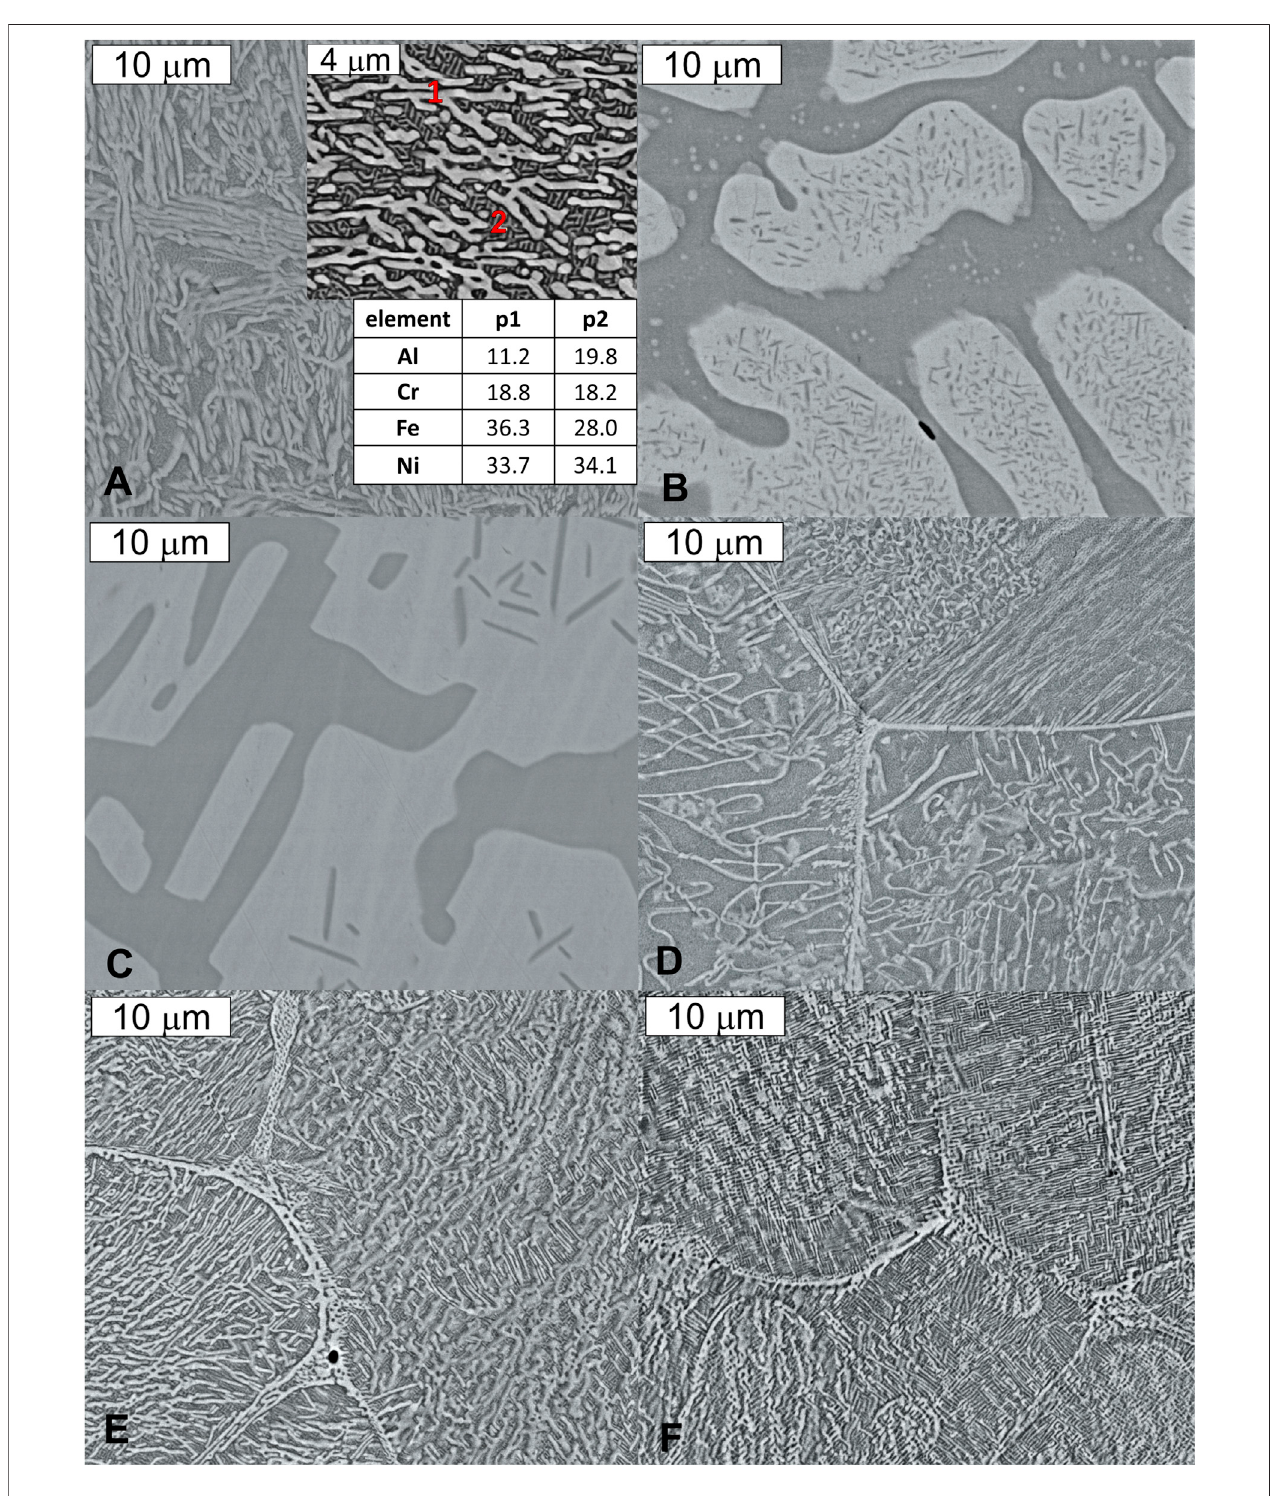
FIGURE 1 | Microstructures of AlCrFe 2 Ni 2 (A) , AlCrFe 2 Ni 2 (1) (B) , AlCrFe 2 Ni 2 (2) (C) , AlCrFe 2 Ni 2 Mo 0.05 (D) , AlCrFe 2 Ni 2 Mo 0.10 (E) , and AlCrFe 2 Ni 2 Mo 0.15 (F) .